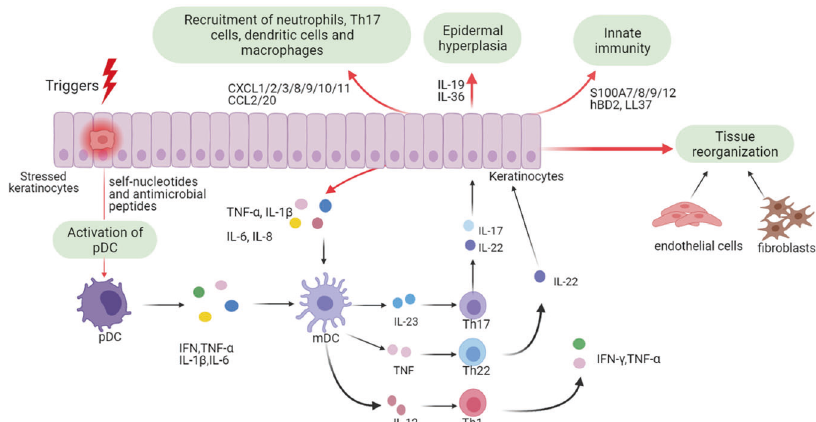
Fig. 1 The role of keratinocytes in psoriasis pathogenesis. This fi gure depicts the pathological process of psoriasis mainly from the keratinocyte perspective. Keratinocytes can be stimulated by initial triggers, and stressed keratinocytes release self-nucleotides and antimicrobial peptide, activate pDCs and subsequent mDCs, involving in the initiation phase of psoriasis. After cytokines stimulation, activated keratinocytes in fl uence psoriasis pathology from aspects of in fl ammatory in fi ltration, epidermal hyperplasia, innate immunity, tissue reorganization, etc. pDCs plasmacytoid dendritic cells, mDCs myeloid dendritic cells, IFN interferon, TNF- α tumor necrosis factor- α , IL-1 β interleukin-1 β , Th1 T helper